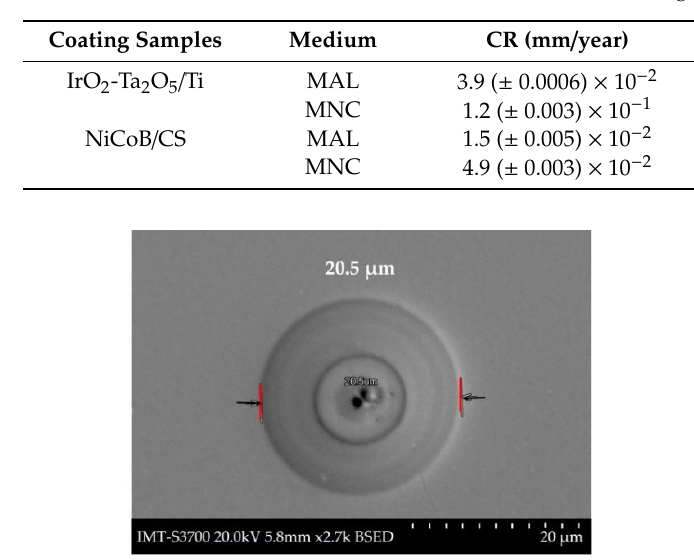
Figure 3. Micrograph of the NiCoB/CS coating exposure to the medium, where a circular form was observed (diameter = 20.5 µm).